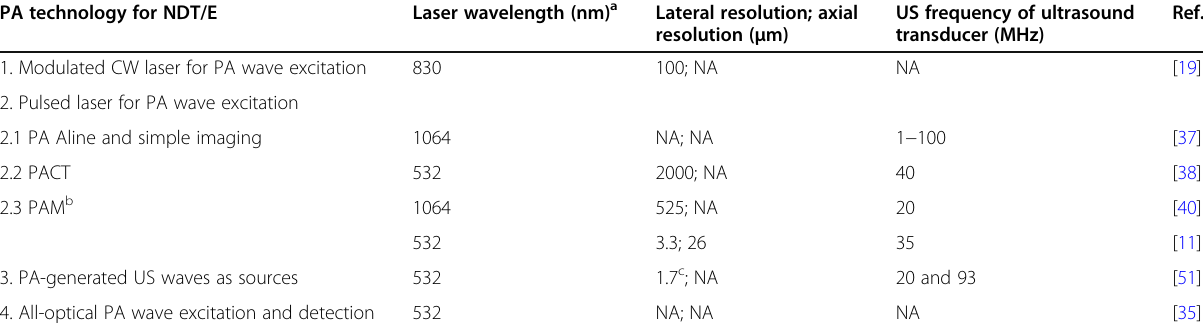
Table 2 Technical specifications of PA technologies used for NDT/E (representative examples) PA technology for